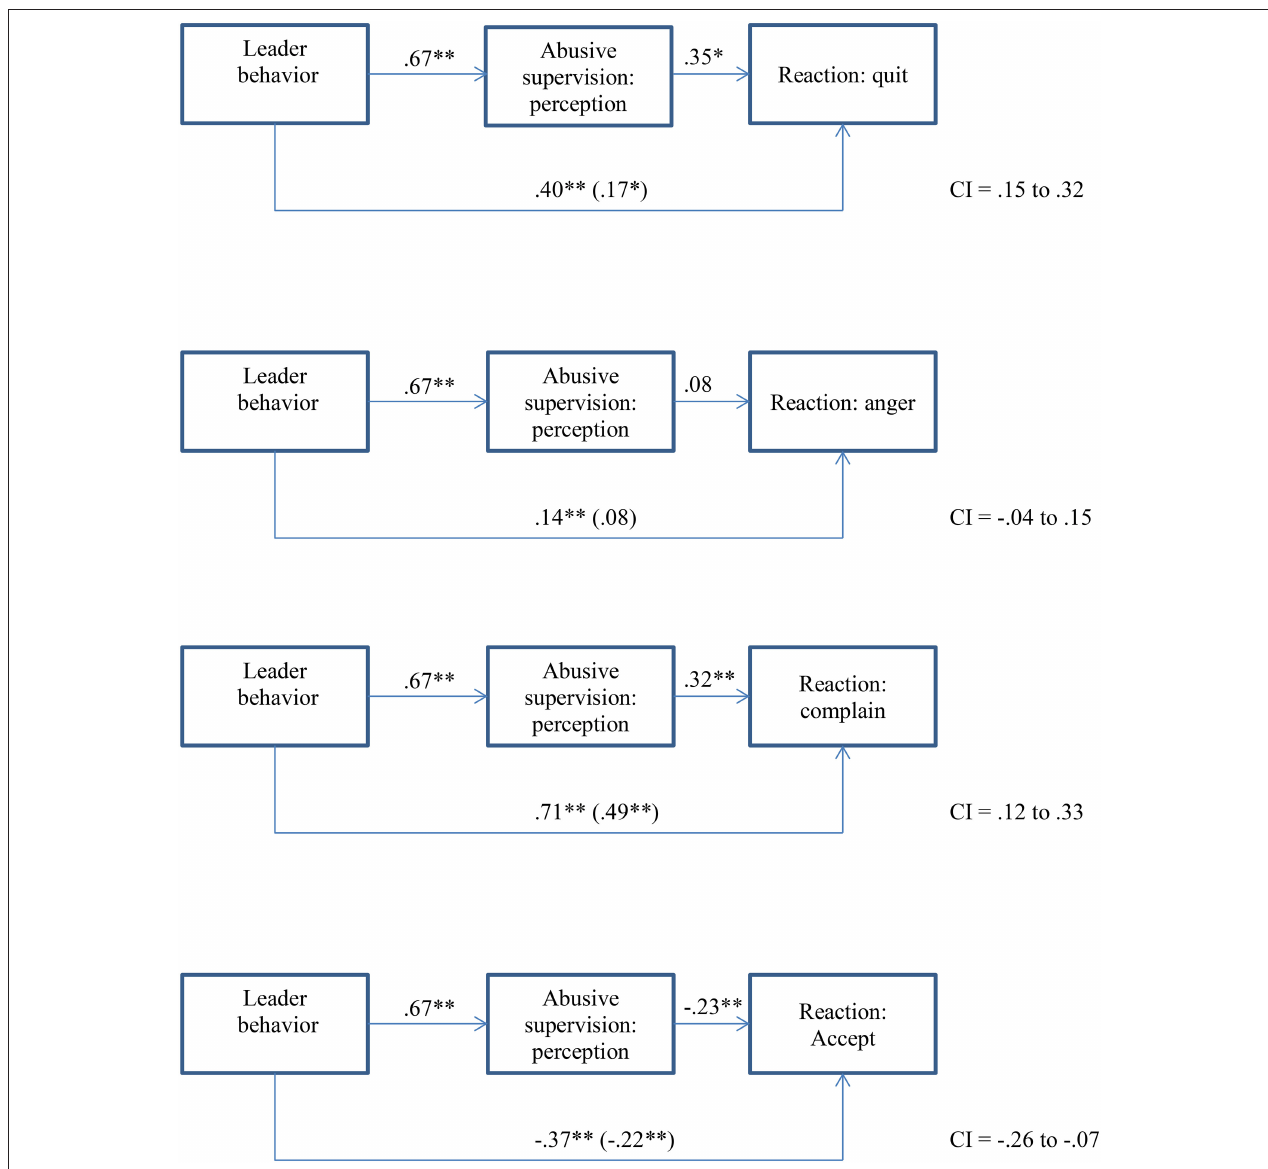
FIGURE 2 | Mediation of perception of abusive supervision on the relationship between abusive supervision behavior and reactions (including controls; Study 1). * p < 0.05 (2-tailed), ** p < 0.01